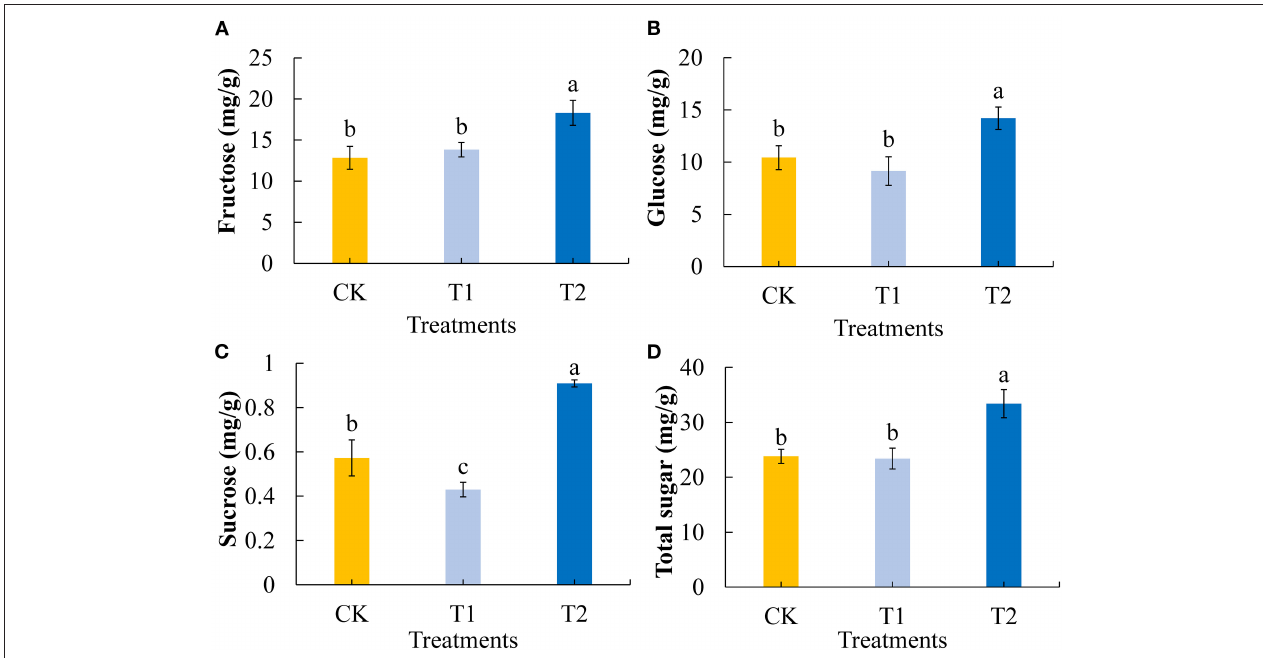
FIGURE 2 | Fructose (A) , glucose (B) , sucrose (C) , and total sugar (D) contents in tomato fruits under different LED supplementary light periods. The data are expressed as average values ± SD ( n = 3). a − c Indicate significant differences between treatments ( P < 0.05, Duncan’s multiple range test). The bars indicate standard errors. CK, no light supplementation control; T1, light supplementation for 3h in the morning; T2, light supplementation for 3h in the